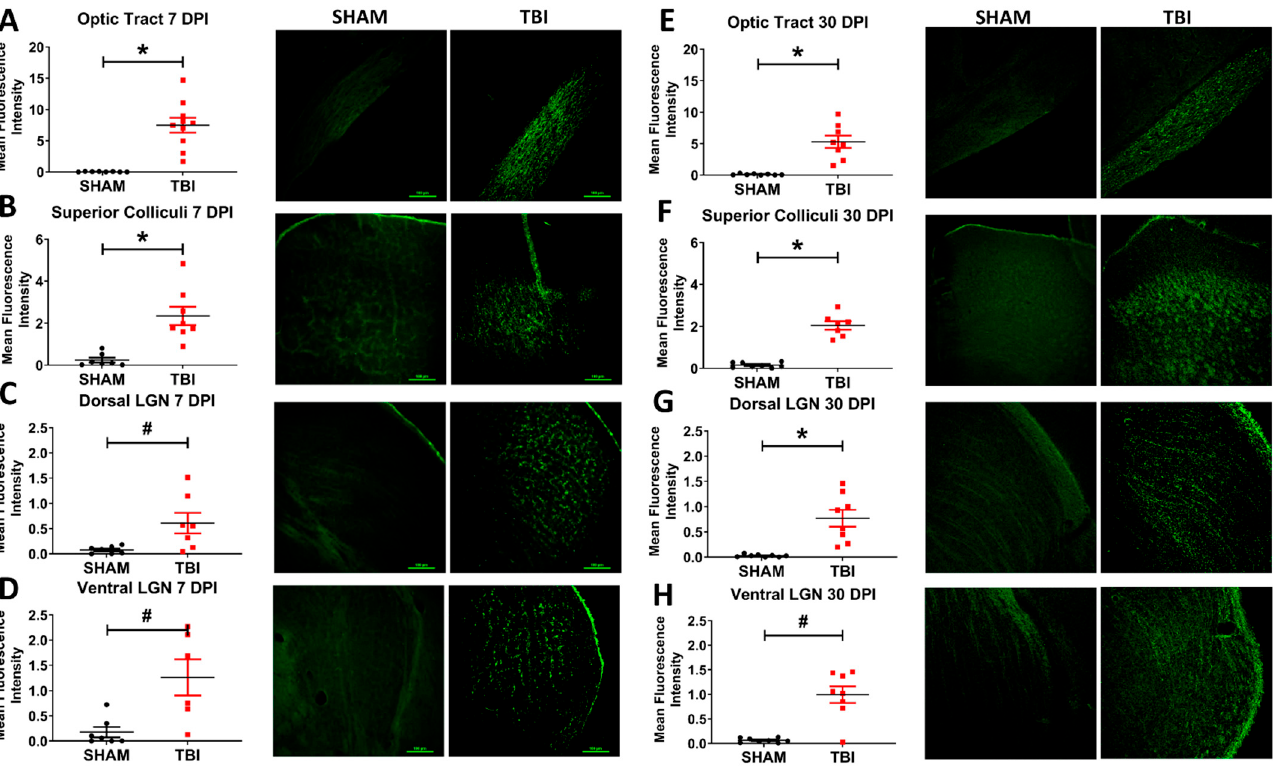
Figure 7. Neurodegeneration in the optic system 7 ( A – D ) and 30 ( E – H ) DPI. Staining appears punctate rather than somatic, consistent with primarily axonal staining. Representative photomicrographs taken at 10× magnification with a scale bar indicating 100 μ m; this applies to all images. * p < 0.001 and # p <0.05.